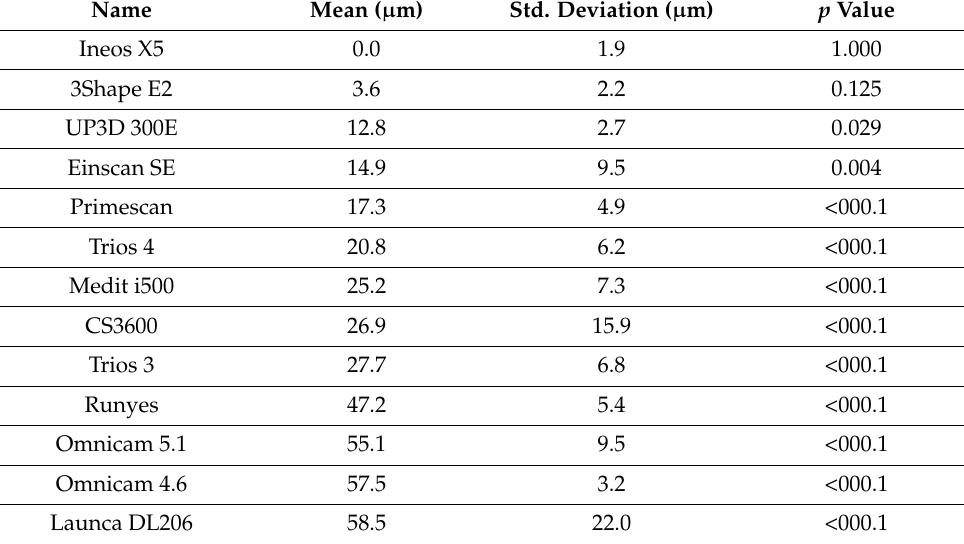
Table 2. Mean trueness and standard deviation of each scanner in comparison to the master scan from the Ineos X5 in order of ascending mean deviation and the significance compared to the Ineos X5 results.